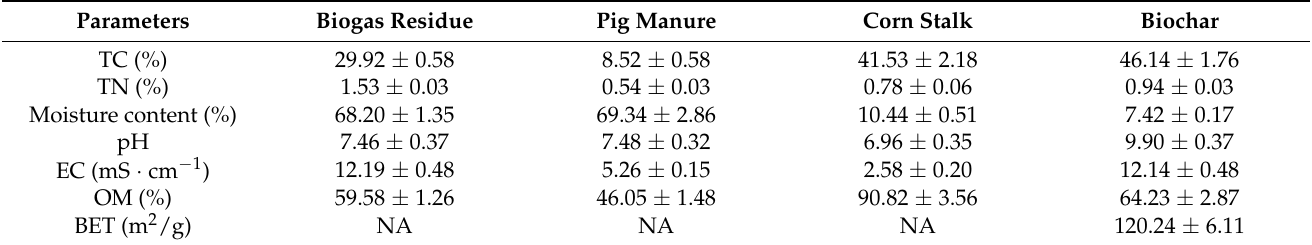
Table 1. Characteristics of the composting raw